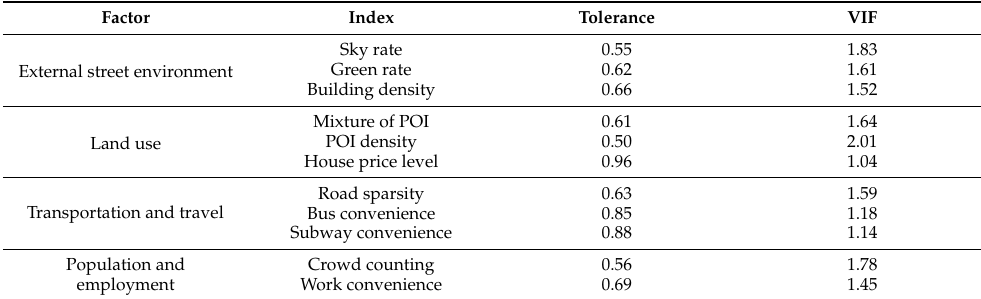
Figure 5. Spatial distribution of the indices of built environment factors on streets. ( a ) Sky rate. ( b ) Green rate. ( c ) Building density. ( d ) Mixture of POI. ( e ) POI density. ( f ) House price level. ( g ) Road sparsity. ( h ) Bus convenience. ( i ) Subway convenience. ( j ) Crowd counting. ( k ) Work convenience. Table 4. Multicollinearity test